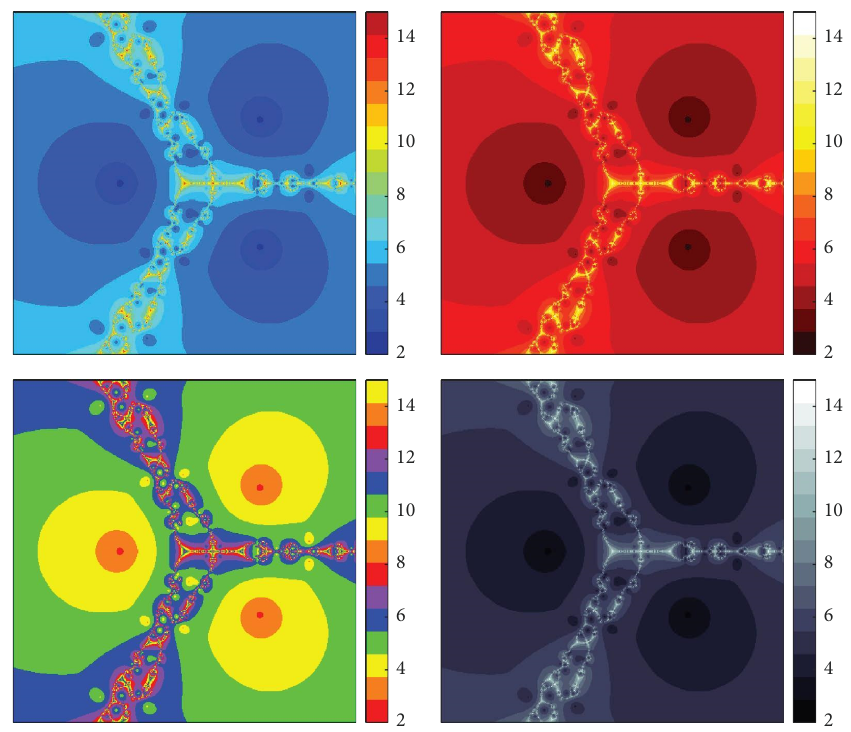
Figure 15: Examples of polynomiographs of diferent color maps for p